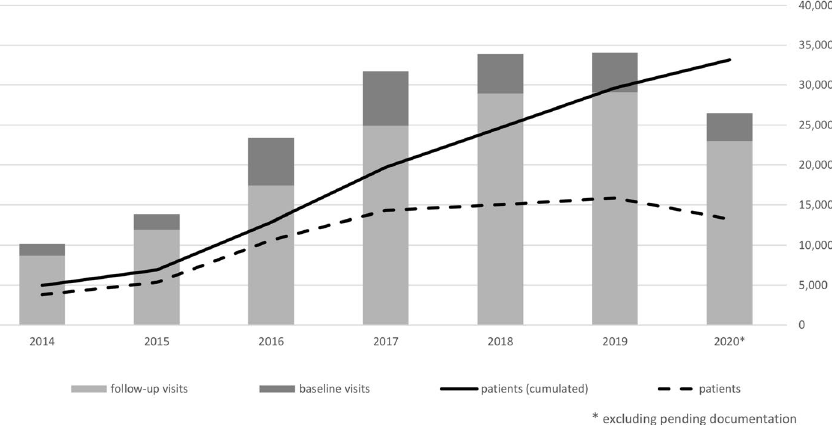
Figure 2. Number of recorded visits per years (by January 2021). Total (cumulative) number of patients included in the GMSR by the end of each year is shown by the black solid line, while the number of patients with actual baseline or follow-up visits during the resp. year is shown by the dashed line. The number of visits per year is show as bars, distinguishing baseline and follow-up visits. GMSR German Multiple Sclerosis registry.